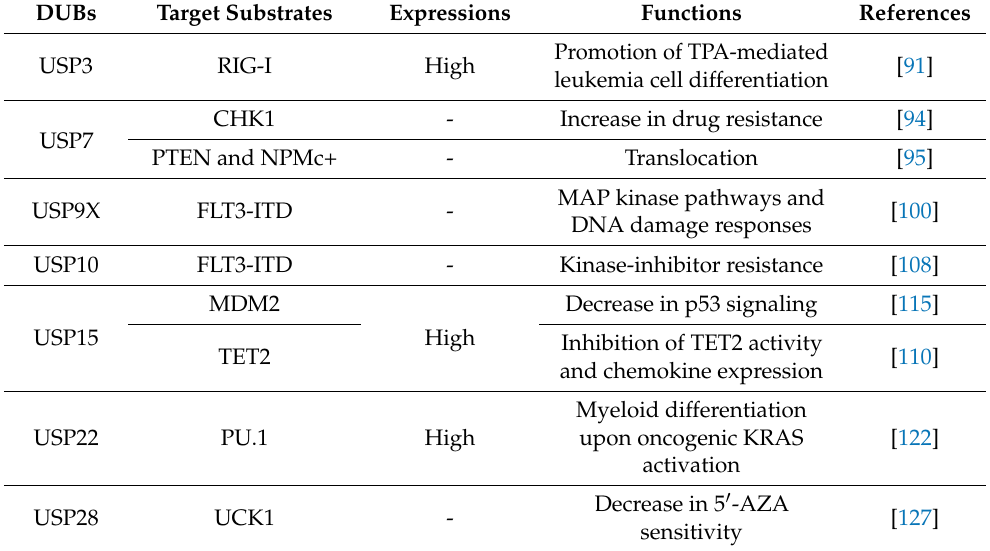
Table 4. Deubiquitination-related enzymes and substrates, and their expressions and functions in